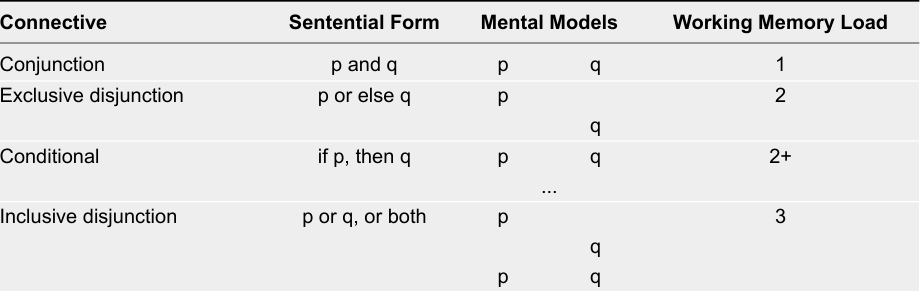
Mental Models for the Main